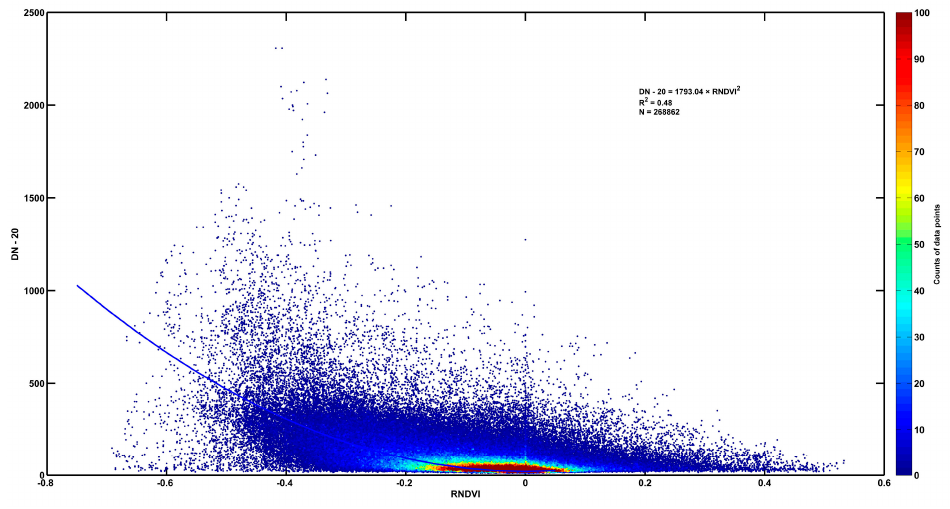
Figure 8. Scatter plot for DN − 20 of the 2006 RCNL image and RNDVI.